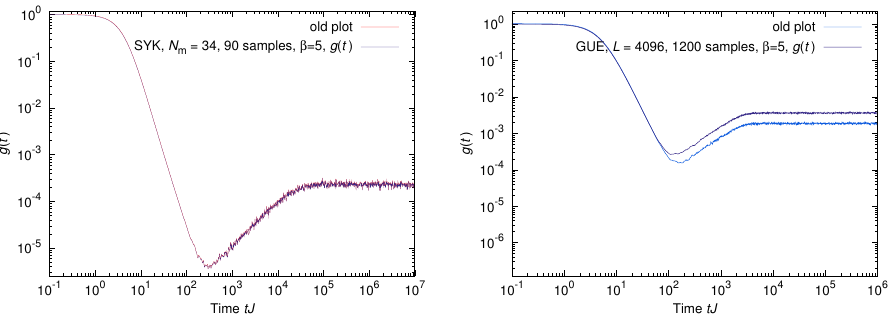
Figure 1 . Left: corrected version of (cid:12)gure 1 in the original publication. The old and corrected data for g ( t ; (cid:12) = 5) obtained for 90 samples of the SYK model with N m = 34 are compared. Right: corrected version of (cid:12)gure 2 in the original publication. The corrected plot of g ( t ; (cid:12) = 5) for 2 12 -dimensional GUE random matrices is shown along with the original plot.